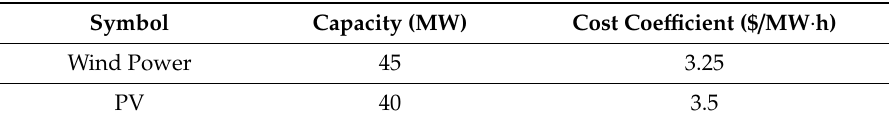
Table 2. Improved BA parameter initialization settings.